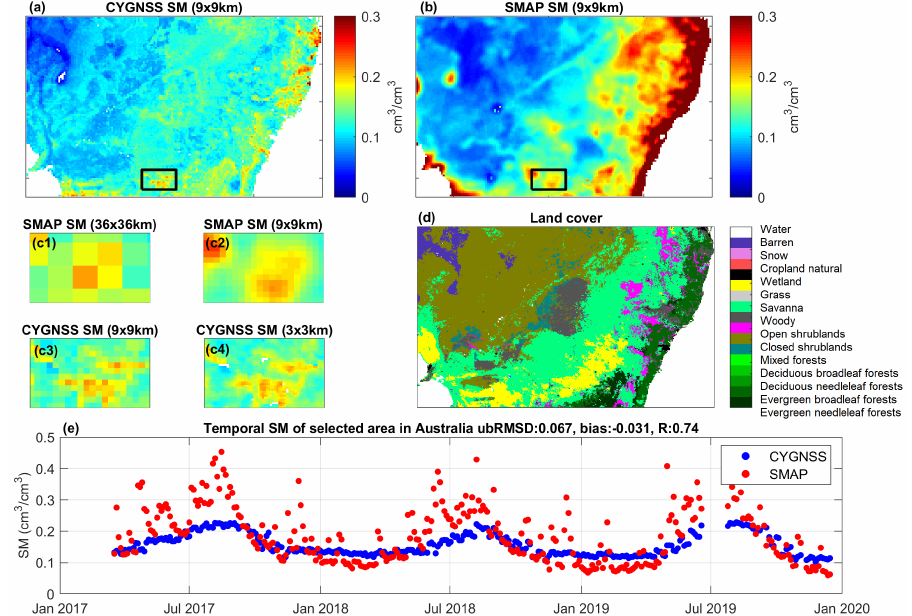
Figure 13. Averaged SM predictions for Australia during Oct 2018. ( a ) CYGNSS 9-km, ( b ) SMAP 9-km, ( c ) detailed images of selected area for SMAP 9-km and 36-km and CYGNSS 3-km and 9-km, ( d ) land cover map, and ( e ) a time-series example from selected